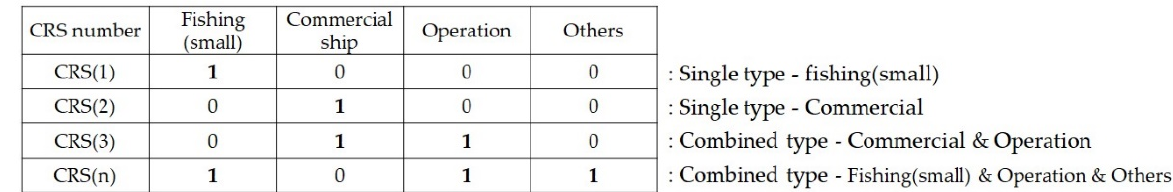
Figure 5. Schematic showing the feature extraction process of a “type of ship” array.